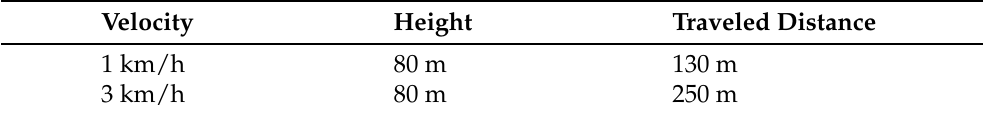
Table 4. Scenario 2 parameters.